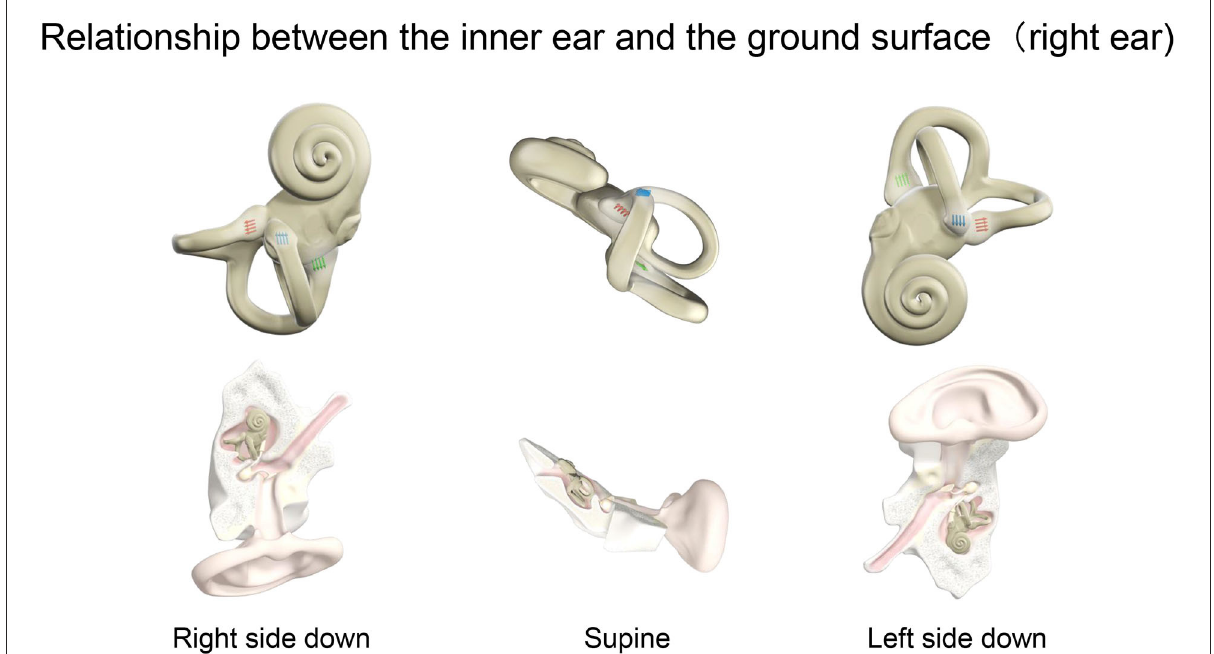
FIGURE5 Relationship between the inner ear and the ground surface (right ear). The positional relationship of the inner ear for right ear side down, supine, and left ear side down in a person lying on the MRI bed. The right inner ear is viewed in the horizontal plane. The ampulla is shown for the three semicircular canals. Blue, red, and green arrows indicate the ampulla in the horizontal, anterior, and posterior semicircular canal, respectively. The direction of the arrows shows the stimulus direction of endolymph movement. In the horizontal canal, ampullopetal flow toward the ampulla causes a stronger stimulus. By contrast, ampullofugal flow leaving the ampulla causes a stronger stimulus in the anterior and posterior canals. Nystagmus, a fast component of eye movement, moves in the opposite direction to the arrows of the three semicircular canals combined.